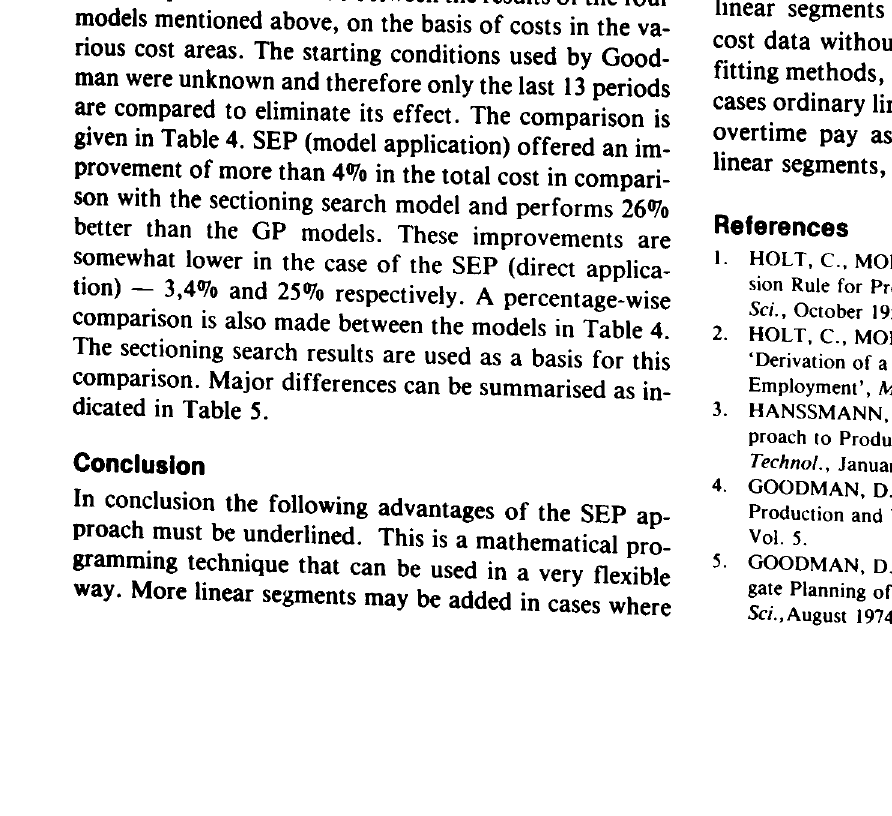
A comparison between the various models, using sectioning search results as a basis Major differences compared to the sectioning search